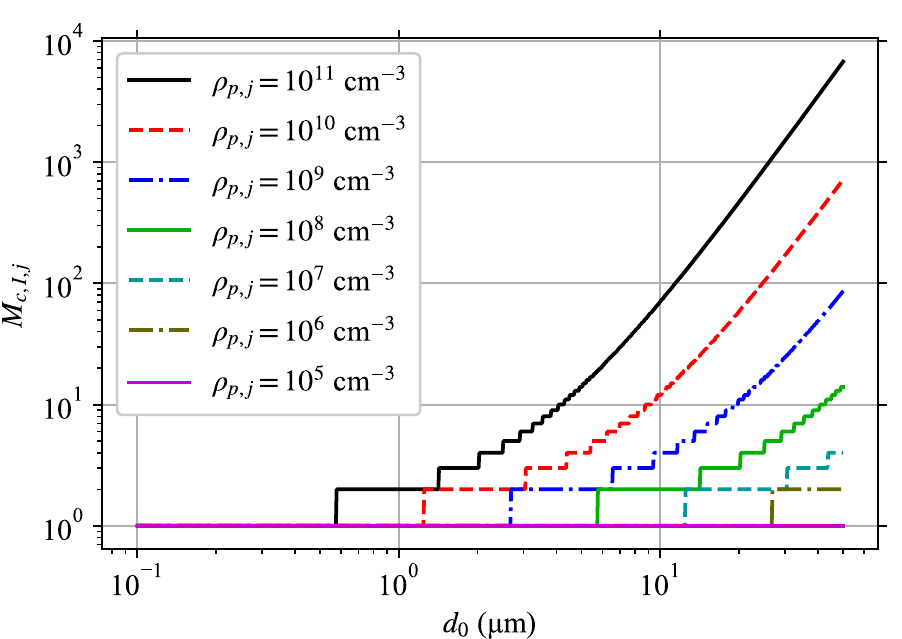
Fig 2. Required M c based on pathogen concentration in infectious individuals. M c , I , j required to capture 99% of pathogen production for each diameter at aerosol production d 0 from an infectious individual, with each line being a different pathogen concentration in their respiratory tract fluid ρ